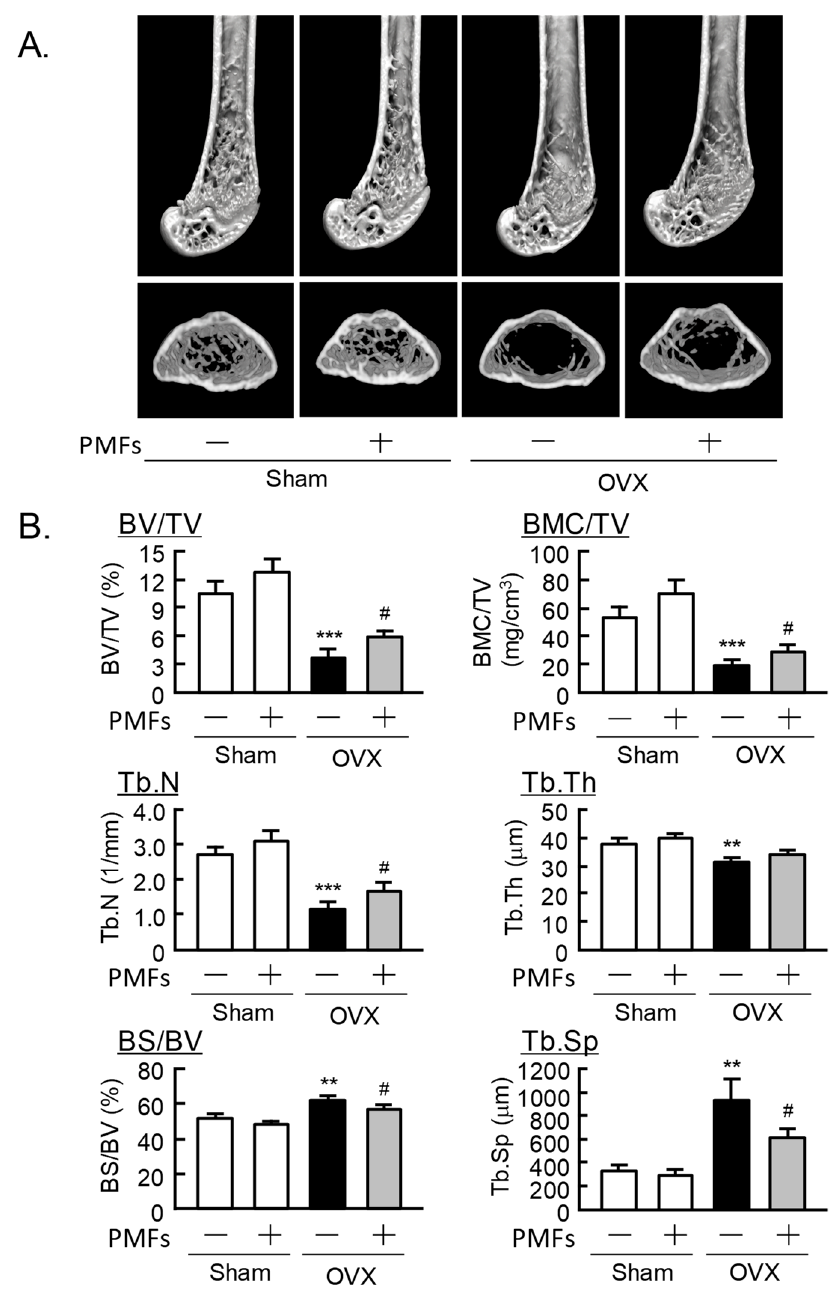
Figure 3. The μ CT analysis of the trabecular bone mass of the distal femur in mice. ( A ) Three- dimensional (3D) μ CT reconstruction images for the distal femur. ( B ) The parameters (BV/TV, BMC/TV, Tb.N, Tb.Th, BS/BV, and Tb.Sp) of trabecular bone were analyzed using μ CT. Data are expressed as the means ± SEM of 6–8 mice. Significant differences between the two groups are indicated; ** p < 0.01 and *** p < 0.001 vs. Sham without PMFs, # p < 0.05 vs. OVX without PMFs.